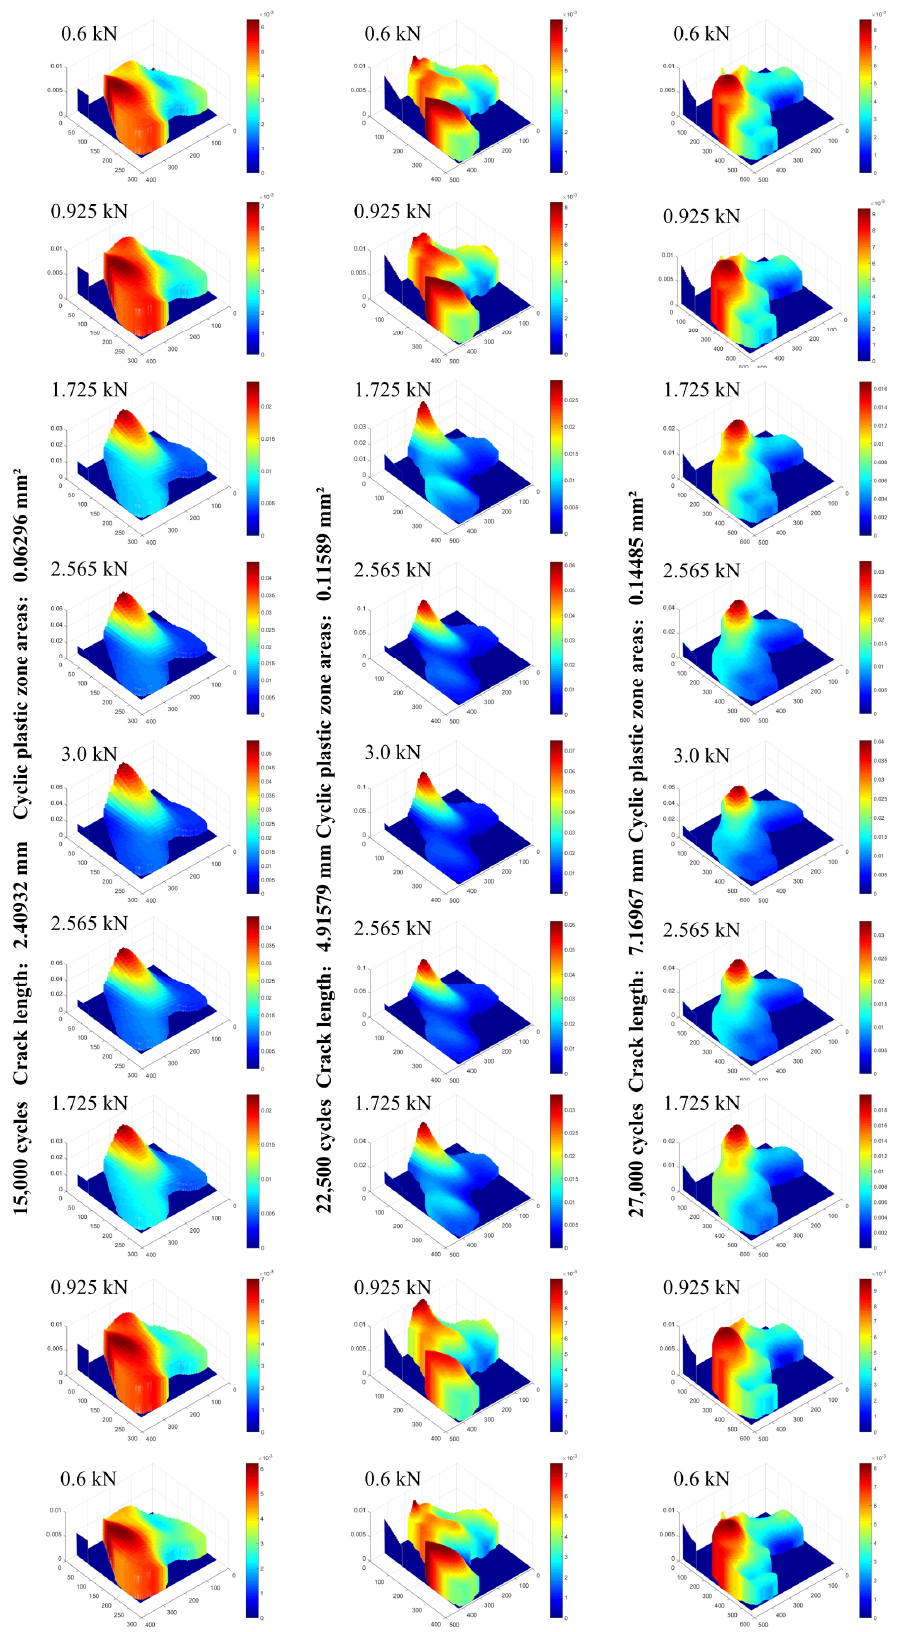
Figure 20. Strain response in the CPZ during a load cycle at different crack lengths.